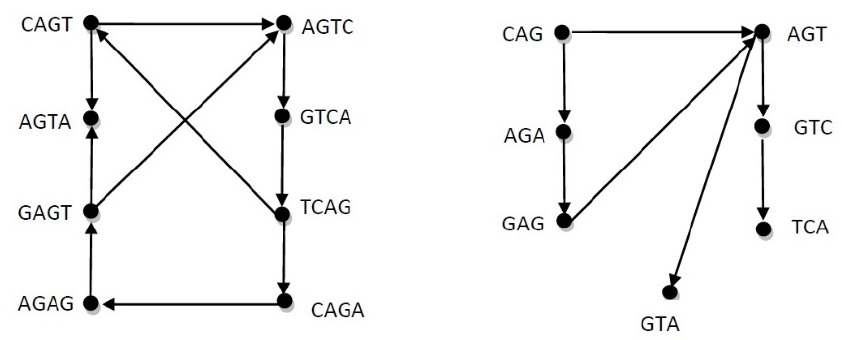
Figure 3. DNA sequencing using graph theory [24–26].